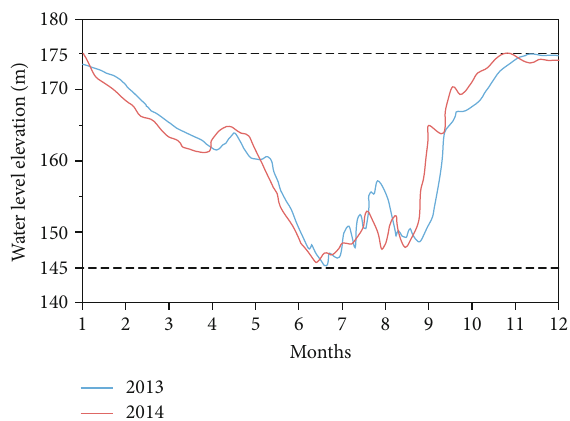
Figure 4: The fl uctuation of reservoir water level from 2013 to 2014.